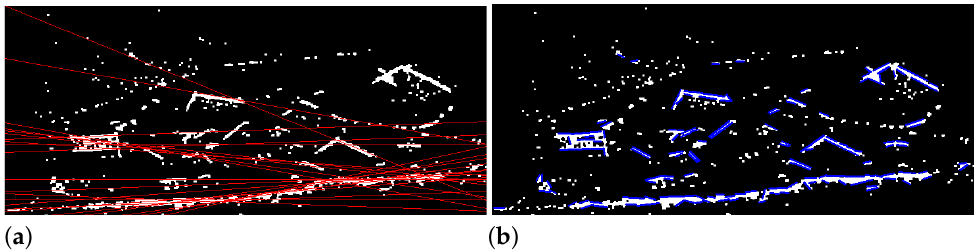
Figure 13. The lines found in the sub-image—comparison of the Hough algorithm ( a ) versus the fast line detector ( b ).